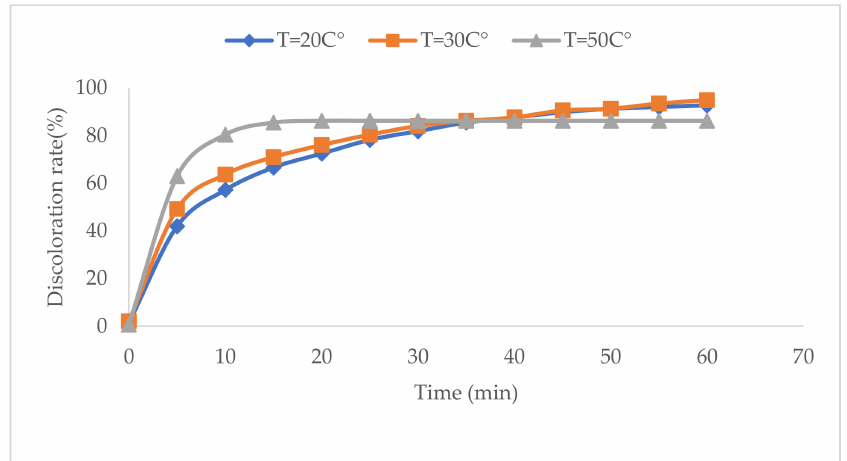
Figure 5. Effect of solution temperature on discoloration rate. Reaction condition: [MO] = 20 mg/L, 50 mM Na 2 SO 4 , I C = 100 mA, pH = 3, [Fe 2+ ] = 0.2 Mm, and [H 2 O 2 ] = 8.8